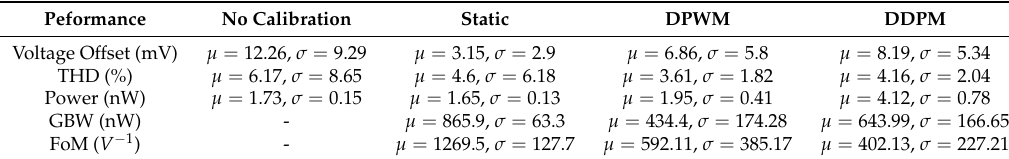
Figure 7. ( a ) Voltage offset ( b ) THD ( c ) Power ( d ) GBW ( e ) and FOM S = 100 GBWC Load Table 1. Monte Carlo simulation results: statistics